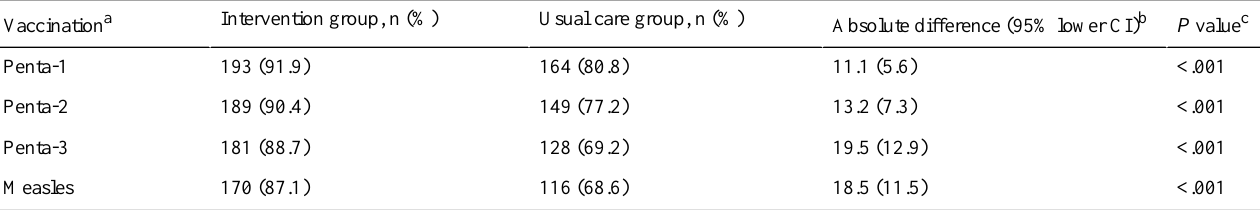
Table 4. Effect of mobile phone text message reminders on timely receipt of specific vaccines in Gondar city, northwest Ethiopia in 2020.